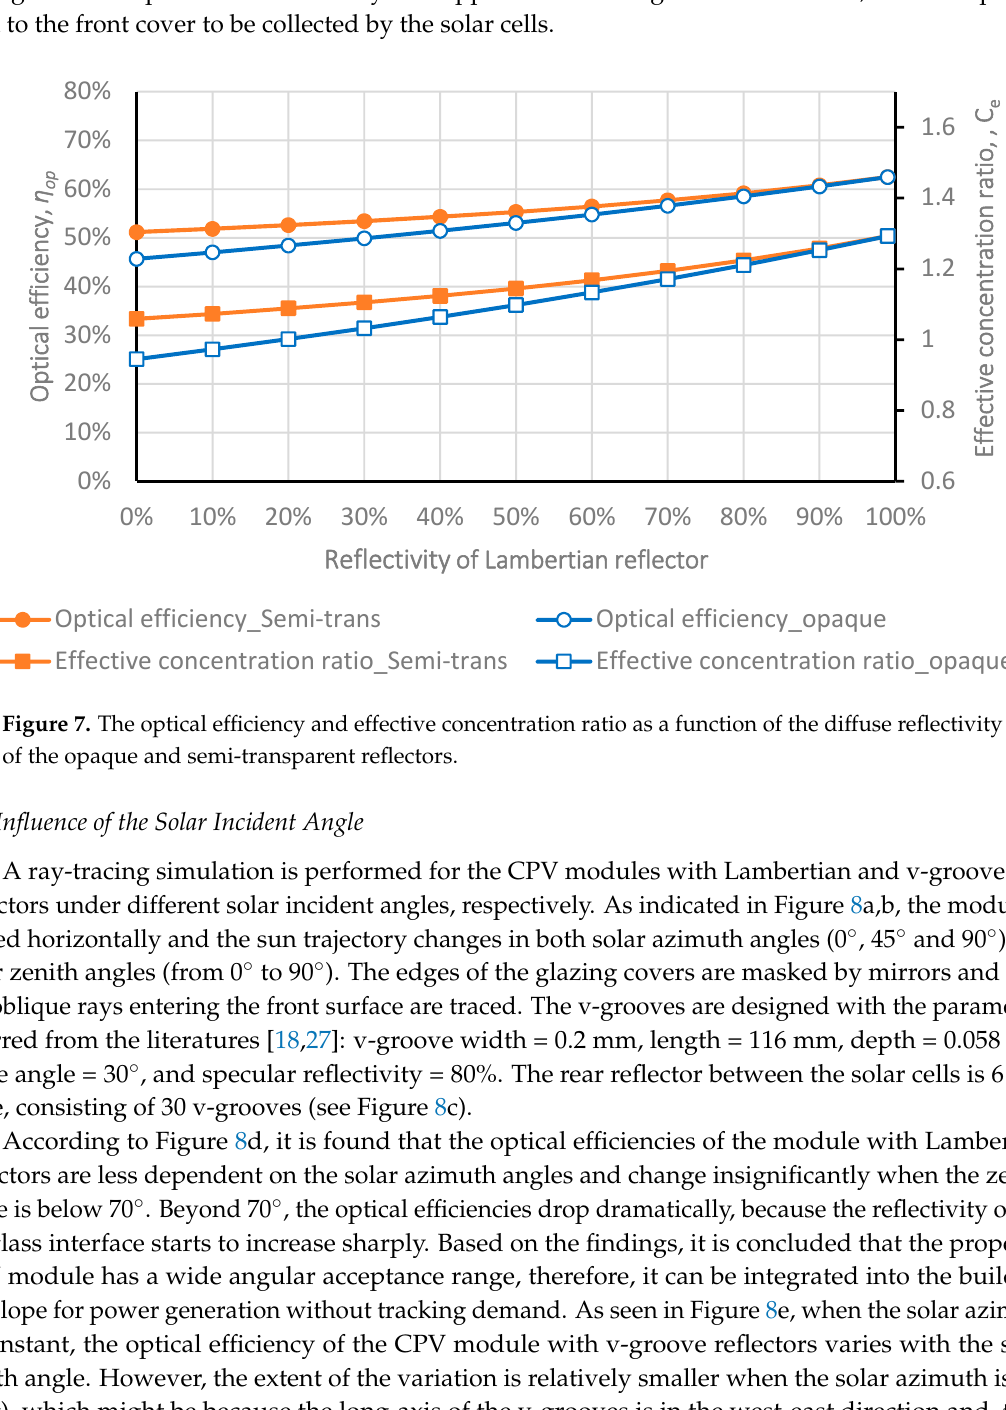
e becomes less than 1.0, which means the CPV system starts to become ineffective